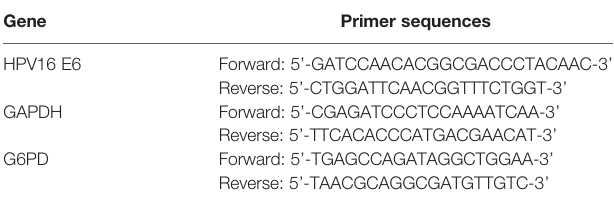
TABLE 2 | Primer sequences used in RT-PCR assays.